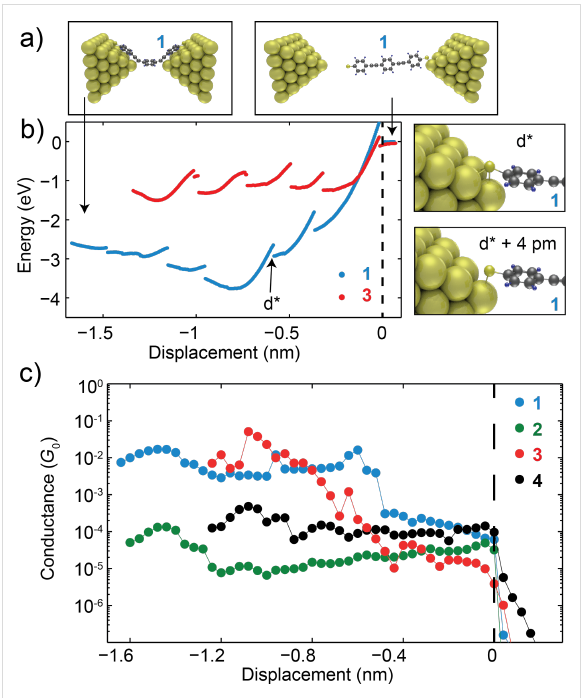
Figure 8: (a) Geometry of the molecular junction 1 at two different positions along the stretching. (b) Binding energy computed from DFT for molecules 1 and 3 as a function of electrodes distance. (c) Conductance of molecules 1 – 4 computed with NEGF at various positions while stretching the